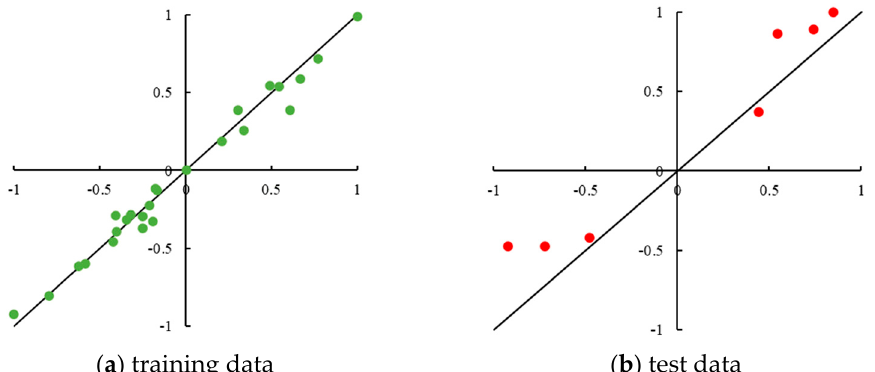
specimen made of rounded aggregates and ( b ) concrete specimen made of angular aggregates.